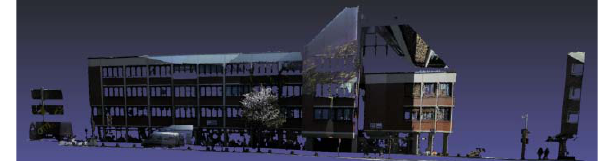
Figure 9. 2 layer model - front view